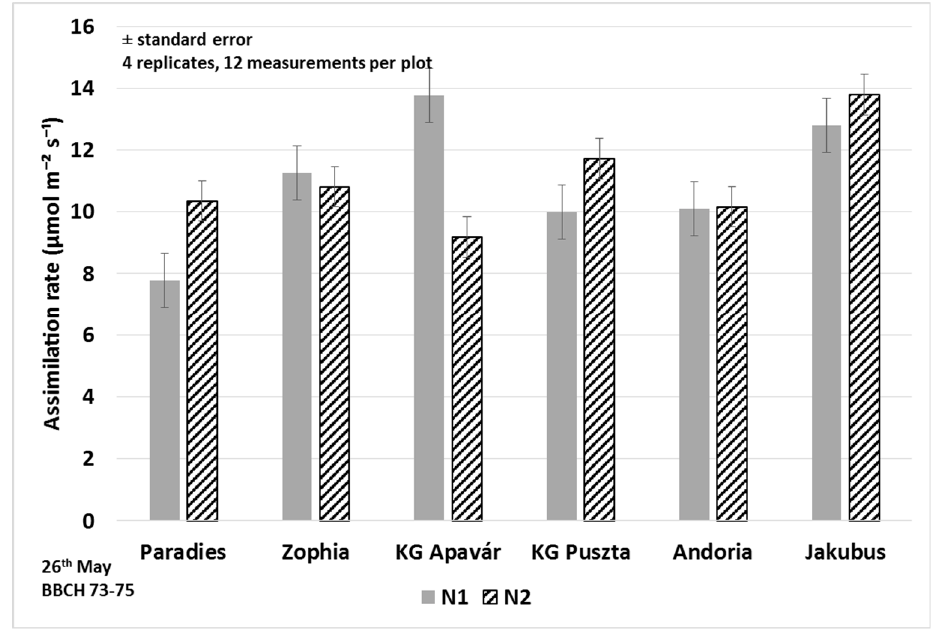
Figure 3. Assimilation rate of winter barley cultivars at different N supply (Debrecen, 2020). Standard error of means, 4 replicates, 12 measurements (2 leaves, 6 recordings per leaf). N fertilization did not cause significant differences in assimilation rate in general, but the cultivars had varying reactions. Table 3. Pearson correlation coefficient values between assimilation parameters in winter barley (2020, Debrecen).